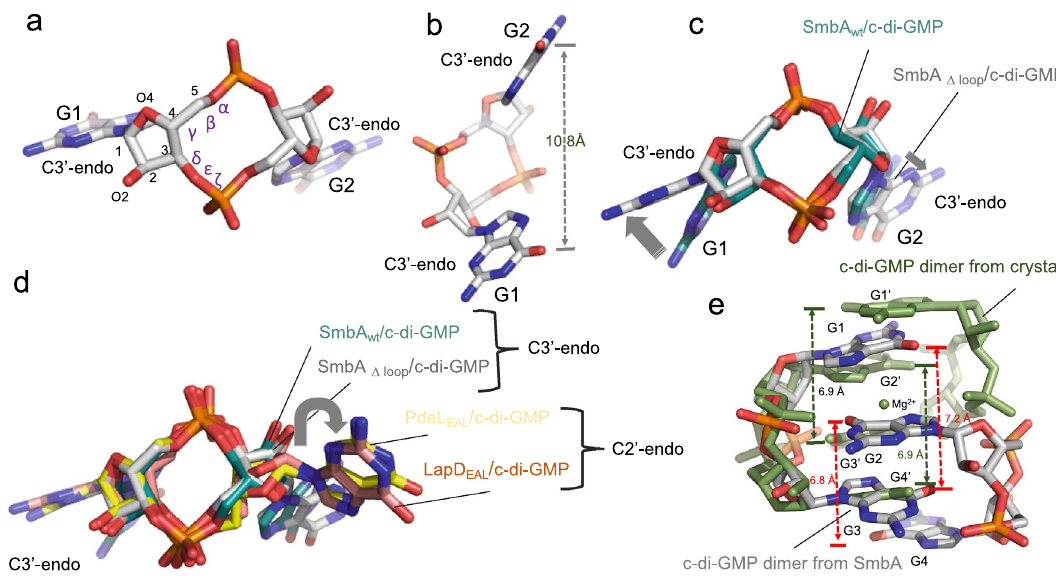
Figure 6. Observed c-di-GMP conformations in SmbA loop and its comparison with SmbA wt , PdeL and LapD. ( a ) and ( b ) shows the partial open-twisted form of monomeric c-di-GMP in C3’-endo sugar pucker conformation observed in SmbA mutant. Guanine distances are shown in black dotted line. ( c ) Superimposition of c-di-GMP from SmbA Δloop , SmbA wt and LapD EAL . GMP moiety from both structures shows the same conformation, the C3 ′ -endo sugar pucker; however, there are considerable differences in the G1 and G2 base orientation (indicated by the gray arrow). ( d ) Superimposition of c-di-GMP from SmbA Δloop with monomeric c-di-GMP as observed when bound to a phosphodiesterase PdeL and degenerated-phosphodiesterase LapD. Distinct sugar pucker of the base at the right (G2) appears responsible for the fully elongated form of c-di-GMP when bound to PdeL or LapD. In contrast, all bases at the left (G1) show the same sugar pucker, i.e. C3 ′ -endo as also observed for SmbA Δloop in this study. ( e ) Superimposition of crystal structure of c-di-GMP/Mg 2+36 and dimeric c-di-GMP from SmbA wt . Guanine distances are shown in red and green dotted lines of c-di-GMP/Mg 2+ and dimeric c-di-GMP from SmbA wt